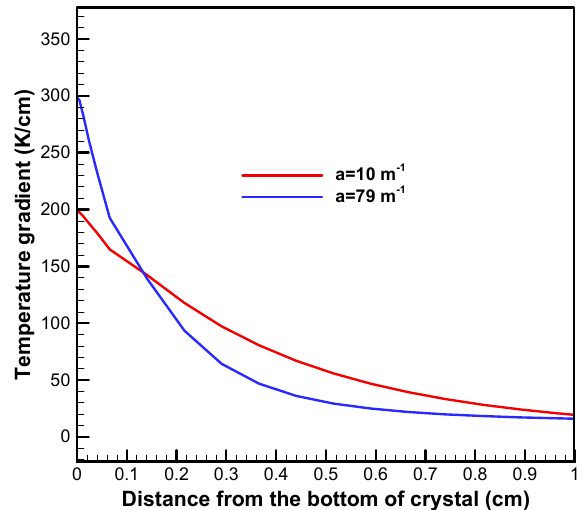
Figure 8. Local distribution of temperature gradient along the centerline of the crystal.